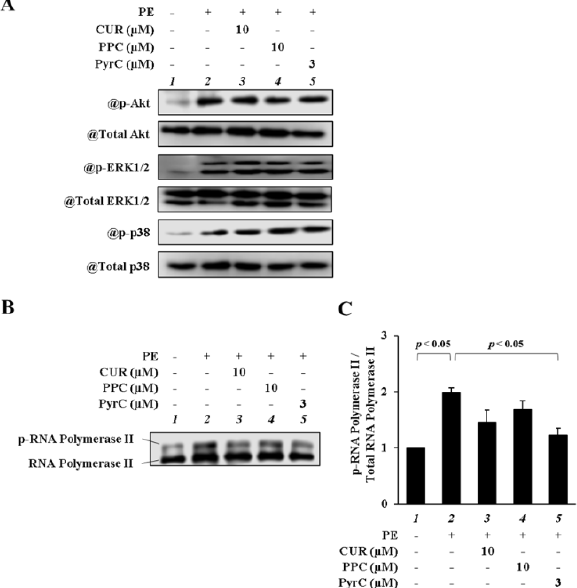
Figure 4. PyrC suppressed the phosphorylation of RNA polymerase II in cardiomyocytes. Primary cultured cardiomyocytes were treated with CUR (10 µ M), PPC (10 µ M), or PyrC (3 µ M) and stimulated with 30 µ M of PE. Whole-cell fraction (15 min after PE stimulation) and nuclear fraction (24 h after PE stimulation) were extracted from theses cardiomyocytes, and all samples were subjected to Western blotting. ( A ) Representative Western blot for p-Akt, total Akt, p-ERK, ERK, p-p38, and total p38. ( B ) Representative Western blot for p-RNA polymerase II and RNA polymerase II. ( C ) Quantifications of ( B ). N = 3.